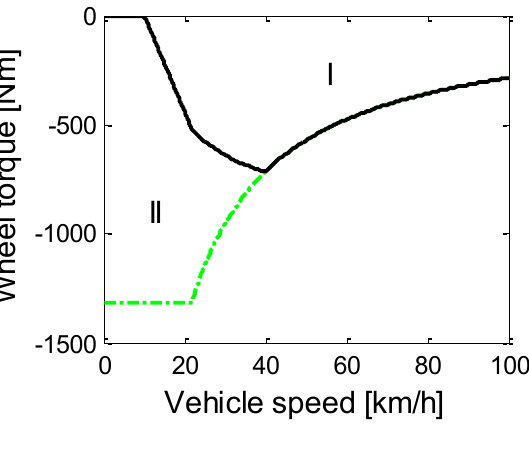
Figure 9. Maximum braking wheel torque characteristic as function of vehicle speed